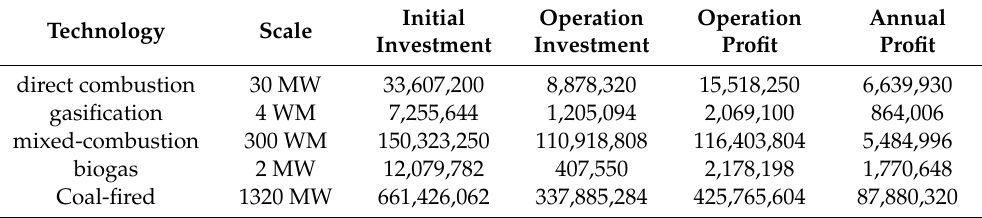
Table 8. Capital inflow–outflow list of di ff erent power generation technologies, Euro ( € ). Technology Scale